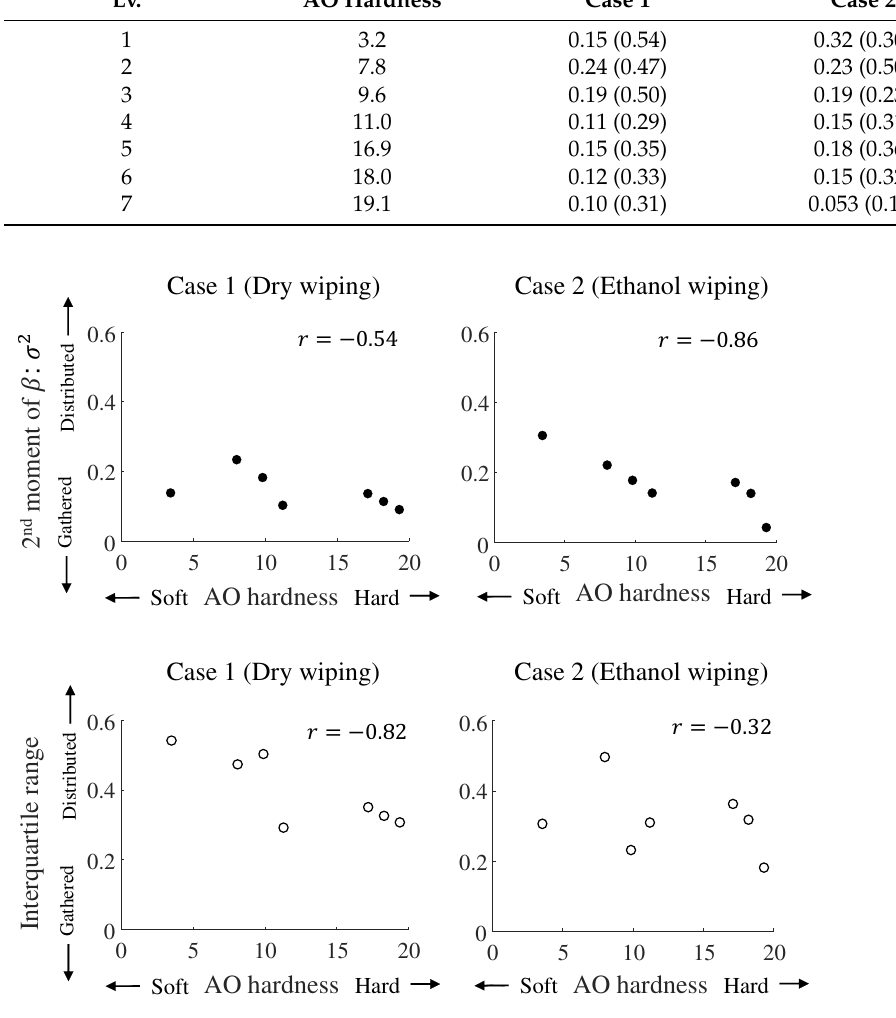
Figure 6. Scatter plots between the second moments (dots) and the interquartile ranges (circles), and AO hardness values of artificial skins. The left and right section represent the results of case 1 (dry-wipe condition) and case 2 (ethanol-wipe condition), respectively. The vertical axis indicates the second moments and the interquartile ranges, with greater values indicating greater variability in β